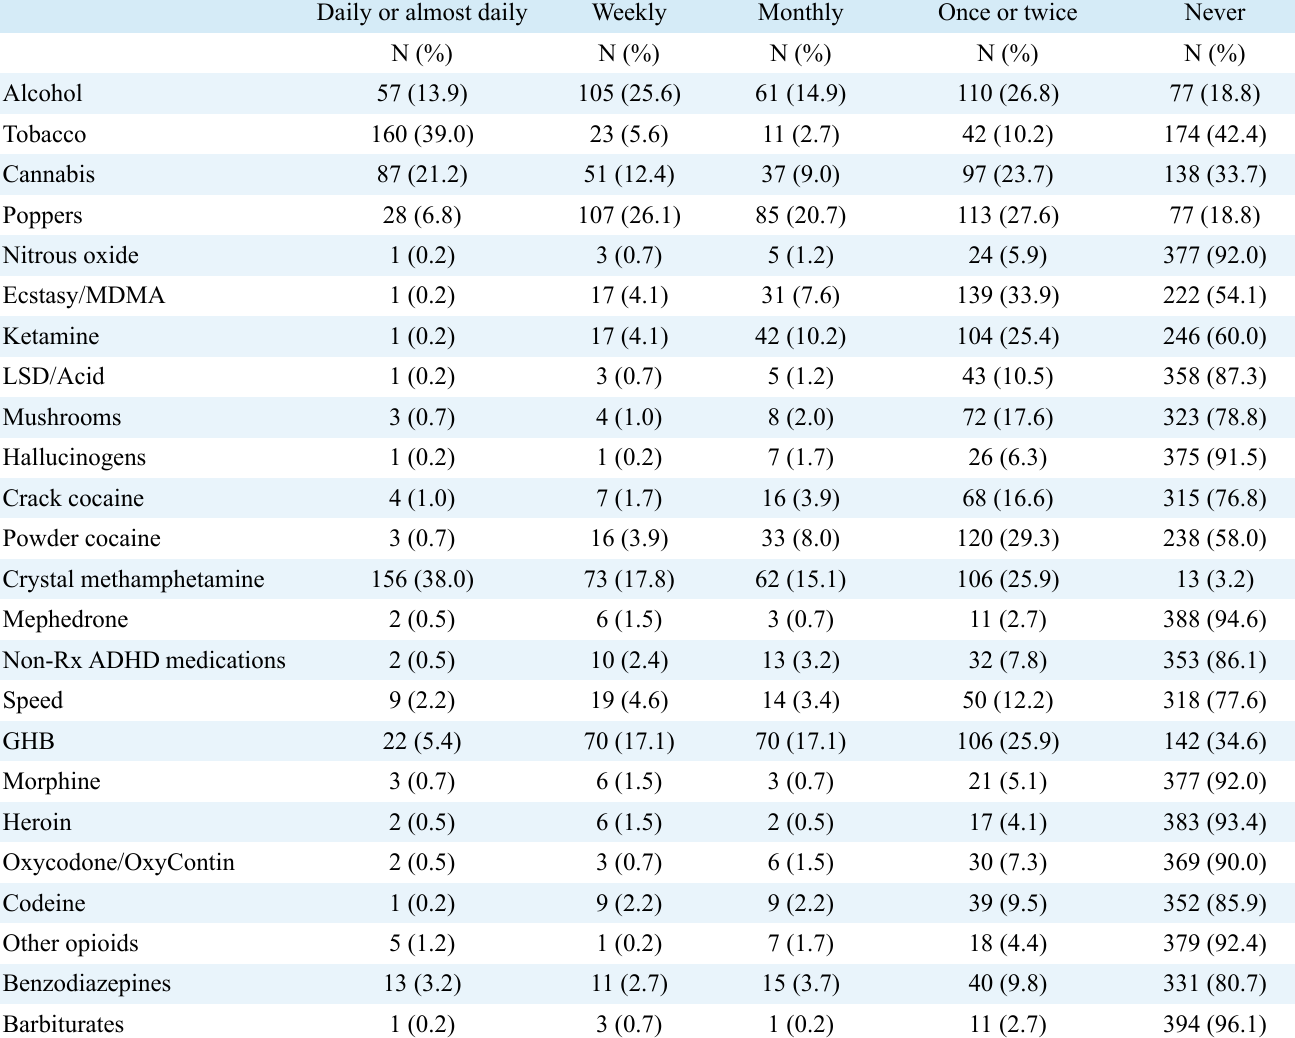
TABLE 2. Frequency of different substance use among sexual minority men and non-binary people who use crystal